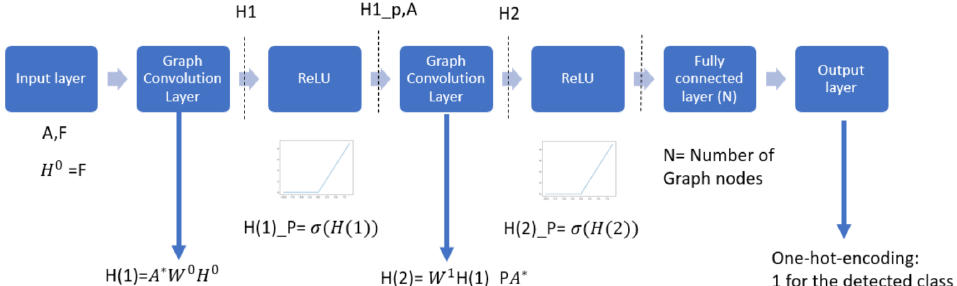
Figure 9. The architecture of the GCN classifier model. Using the fast approximation of spectral convolution, H1 and H2 are the output of the first and second convolution layers, calculated using A ∗ , the normalized Adjacency matrix [41], a. ReLU layers remove the negative values, and finally, the SoftMax layer votes for the detected